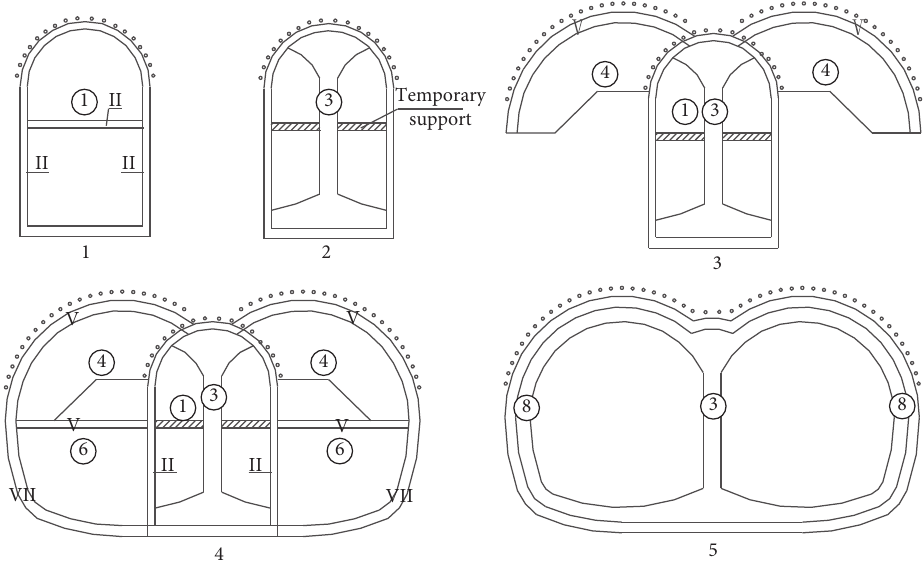
Figure 5: Step diagram of section tunnel construction.